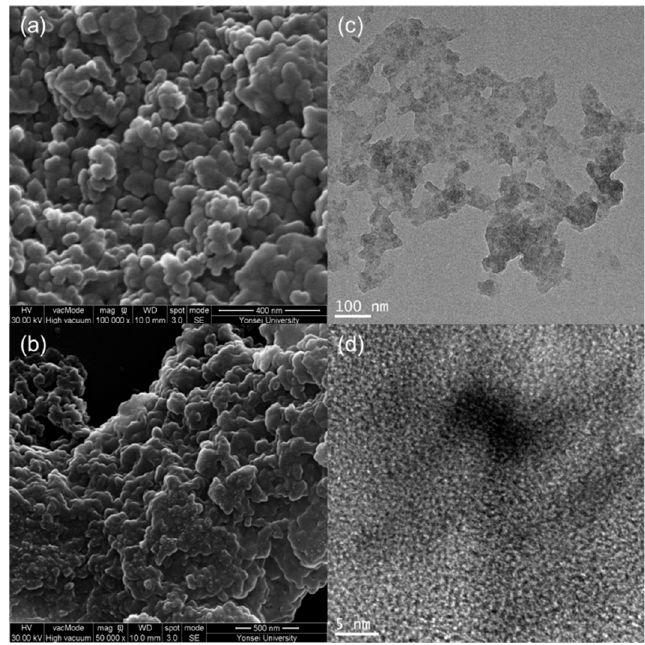
Figure 7. Morphology of NPSOH. SEM images ( a , b ) and TEM images ( c , d ).